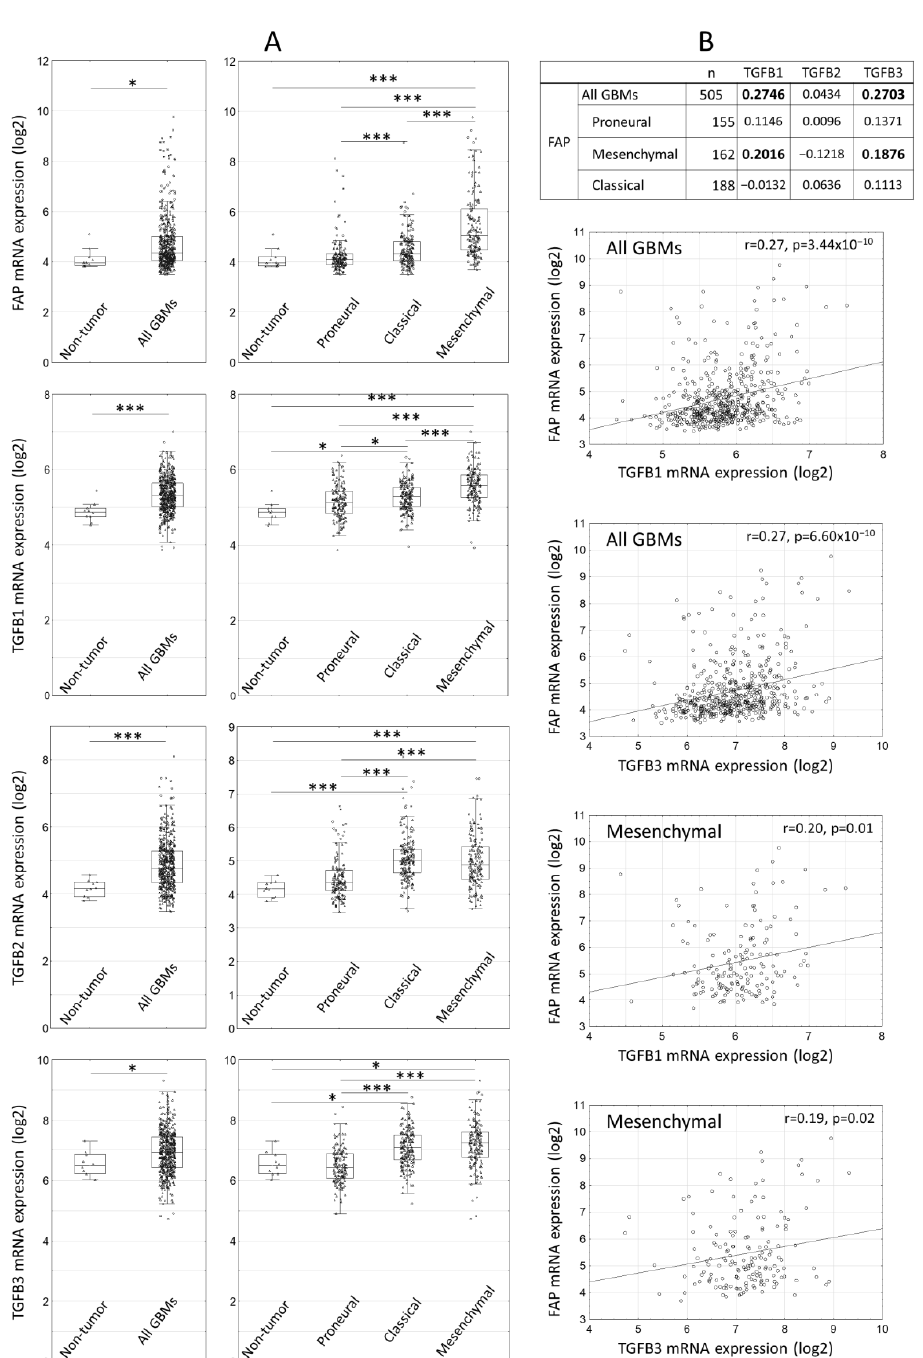
Figure 2. FAP and TGFbeta expression in molecular subtypes of primary glioblastomas (GBMs) according to The Cancer Genome Atlas (TCGA) data. ( A ) Expression of FAP and individual isoforms of TGFbeta mRNA in GBMs and individual molecular subtypes compared to control brain tissues. Line—median, box—25th–75th percentile, whiskers—non-outlier range, triangles—raw data, circles—outliers, asterisk—extremes; * p < 0.05, *** p < 0.001, Mann–Whitney U test and Kruskal–Wallis one way ANOVA on ranks. ( B ) Correlation between FAP and individual TGFbeta isoforms in all GBMs and in individual molecular subtypes of GBM (Pearson correlation coefficient, correlations with p < 0.05 are in bold). Scatter plots are shown only for statistically significant correlations.